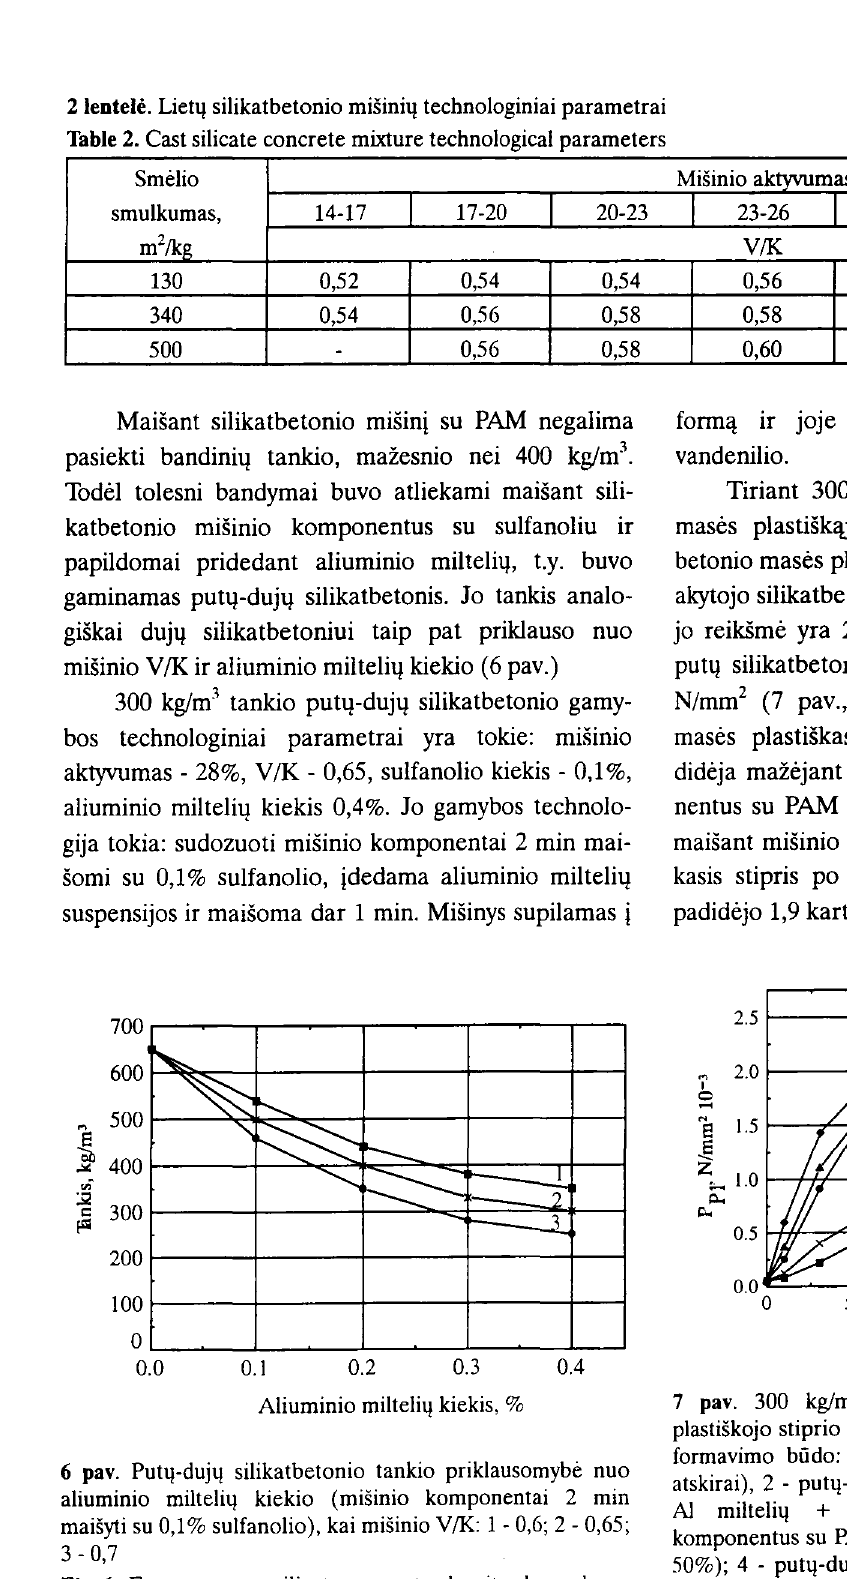
Fig 7. Porous silicate concrete (300 kg/m 3 ) mass plasticity strength dependency on its type and structure formation method: 1 - foam silicate concrete (foam made separately), 2 - Foam-gaseous silicate concrete (25% pores due to Al powder + 75% pores produced by mixing components with SAM), 3 - Foam-gaseous silicate concrete (50% + 50% ), 4 - Foam-gaseous silicate concrete (75% + 25% ), 5 - Gaseous silicate concrete (without